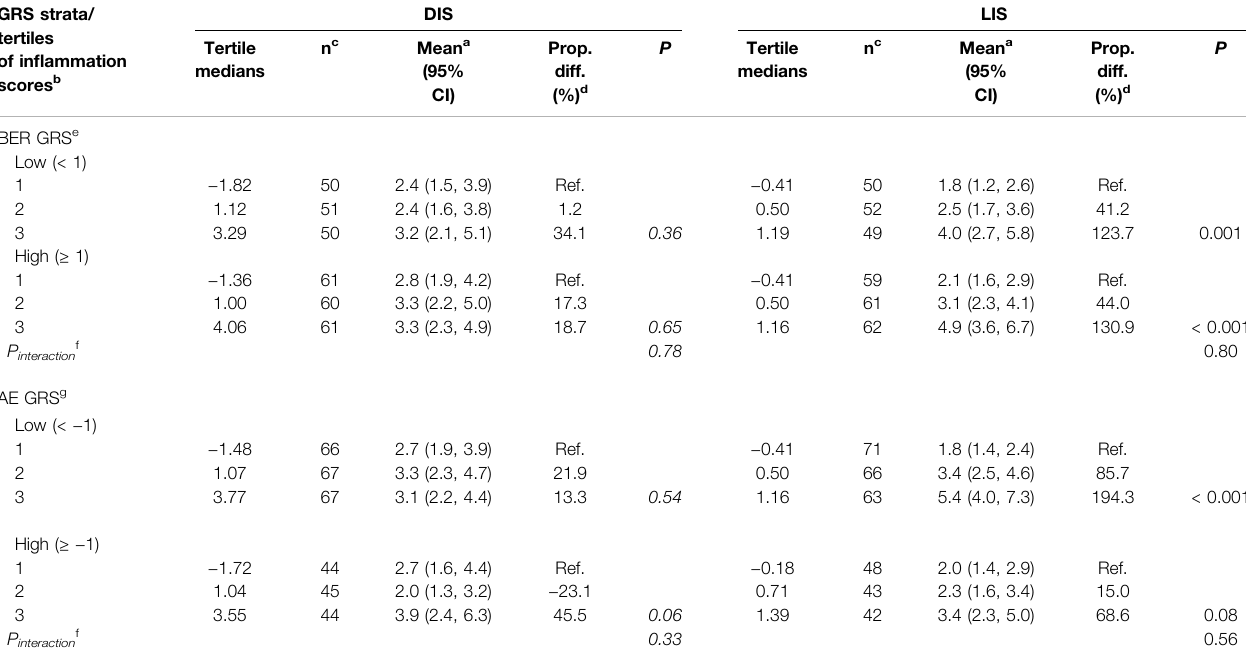
TABLE 4 | Multivariable-adjusted mean a plasma high sensitivity C-reactive protein (hsCRP) concentrations (µg/ml) across tertiles of dietary (DIS) and lifestyle (LIS) in fl ammationscores, strati fi edby dichotomized DNAbase excision repair (BER) and antioxidantenzymes(AE) genetic riskscores(GRS),inthe pooled MAPIand MAP II cross-sectional